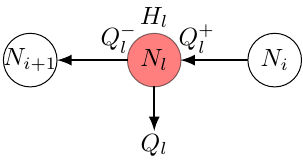
Figure 5. Leak characterization scheme.